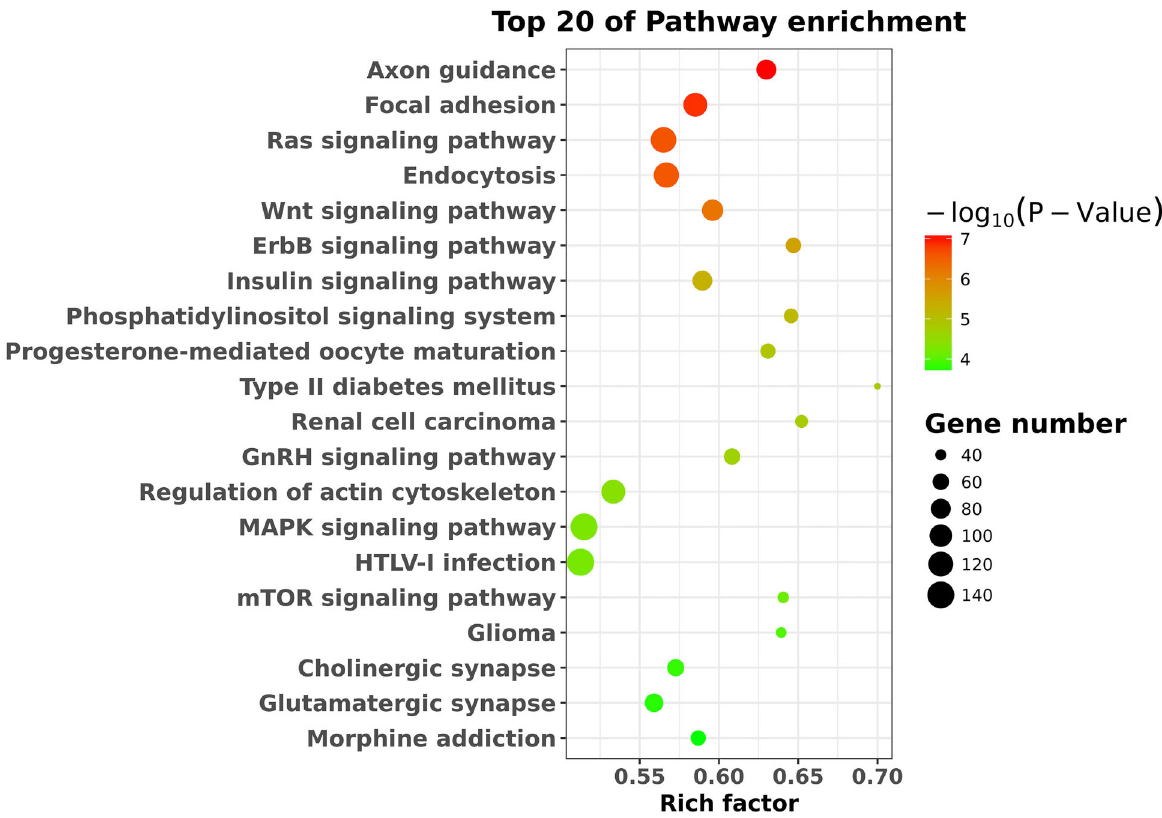
Figure 4. Pathway analysis of the target genes of differentially expressed miRNAs using Kyoto Encyclopedia of Genes and Genomes (KEGG) pathway enrichment analysis. The top 20 pathways are shown.